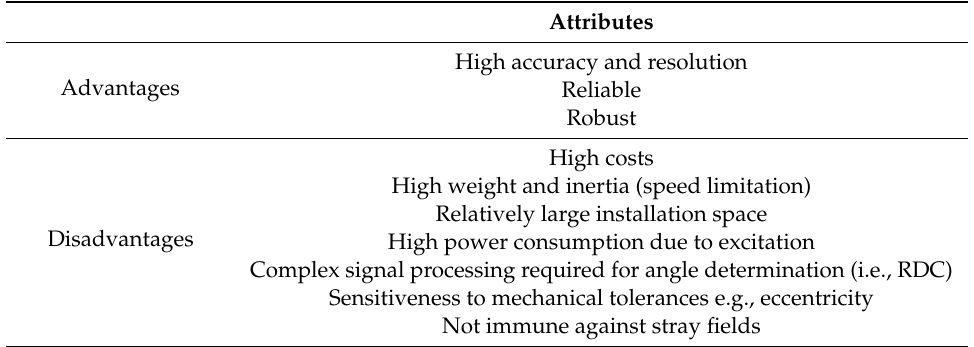
Table 1. Property summery of VR